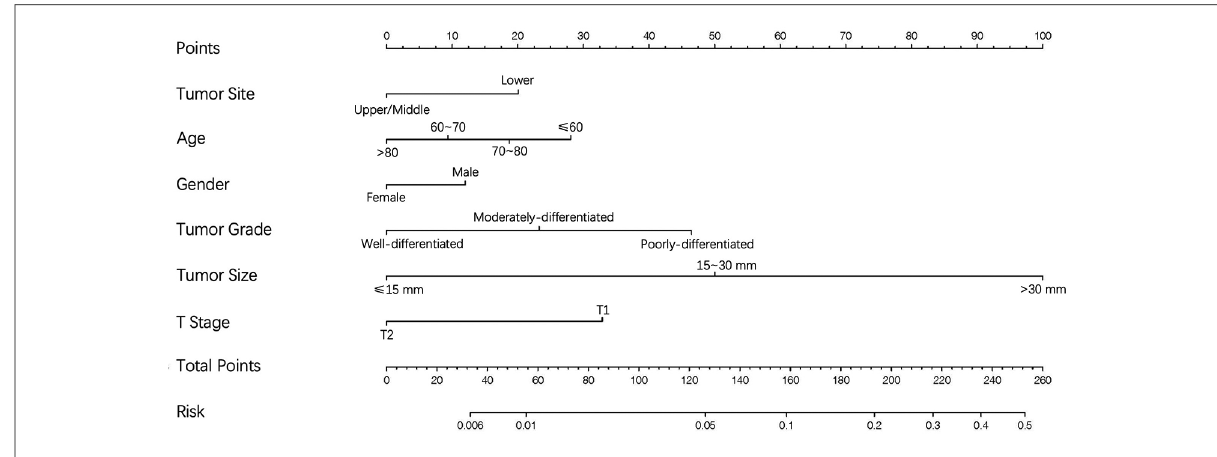
FIGURE 2 Venn diagram of the distribution of bone metastases, brain metastases, liver metastases and lung metastases from 2010 to